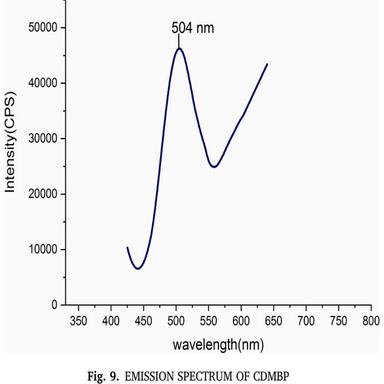
DECAY CURVE